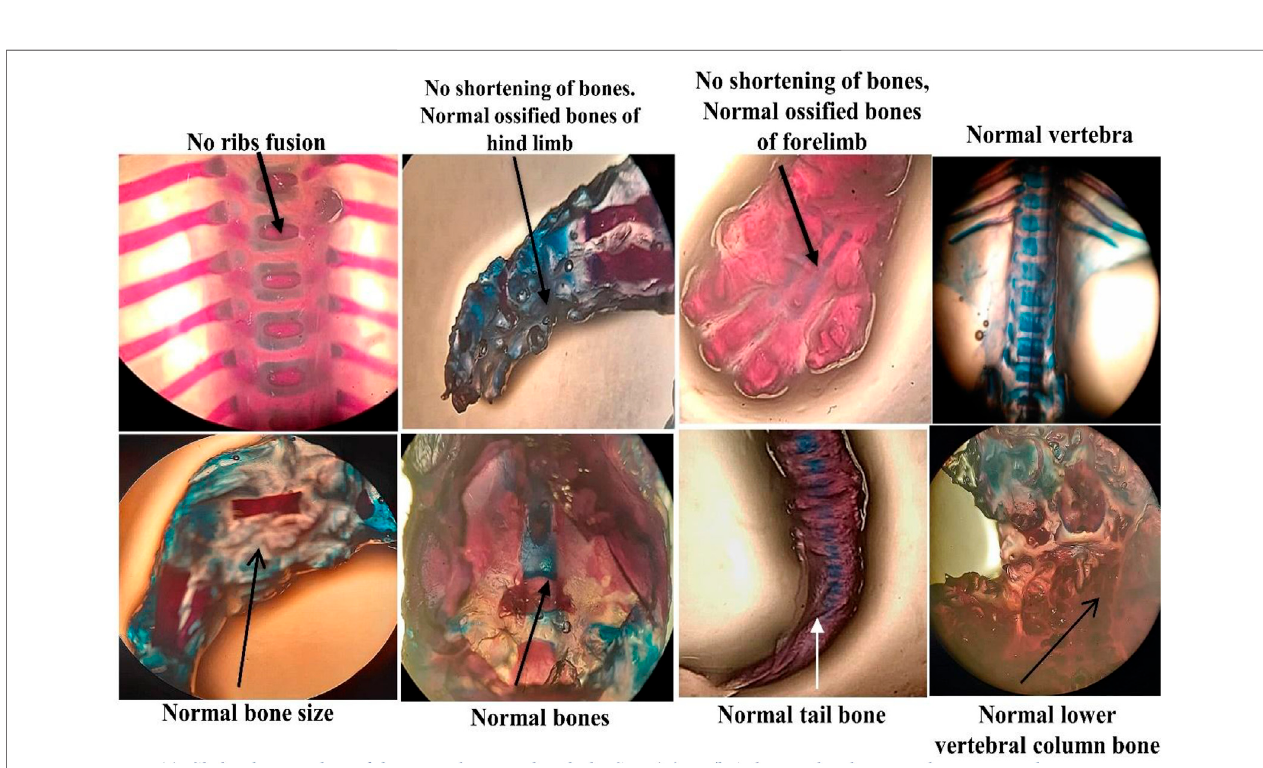
FIGURE 11 | Skeletal anomalies of the animals treated with SF5 (40 mg/kg) during developmental toxicity study.